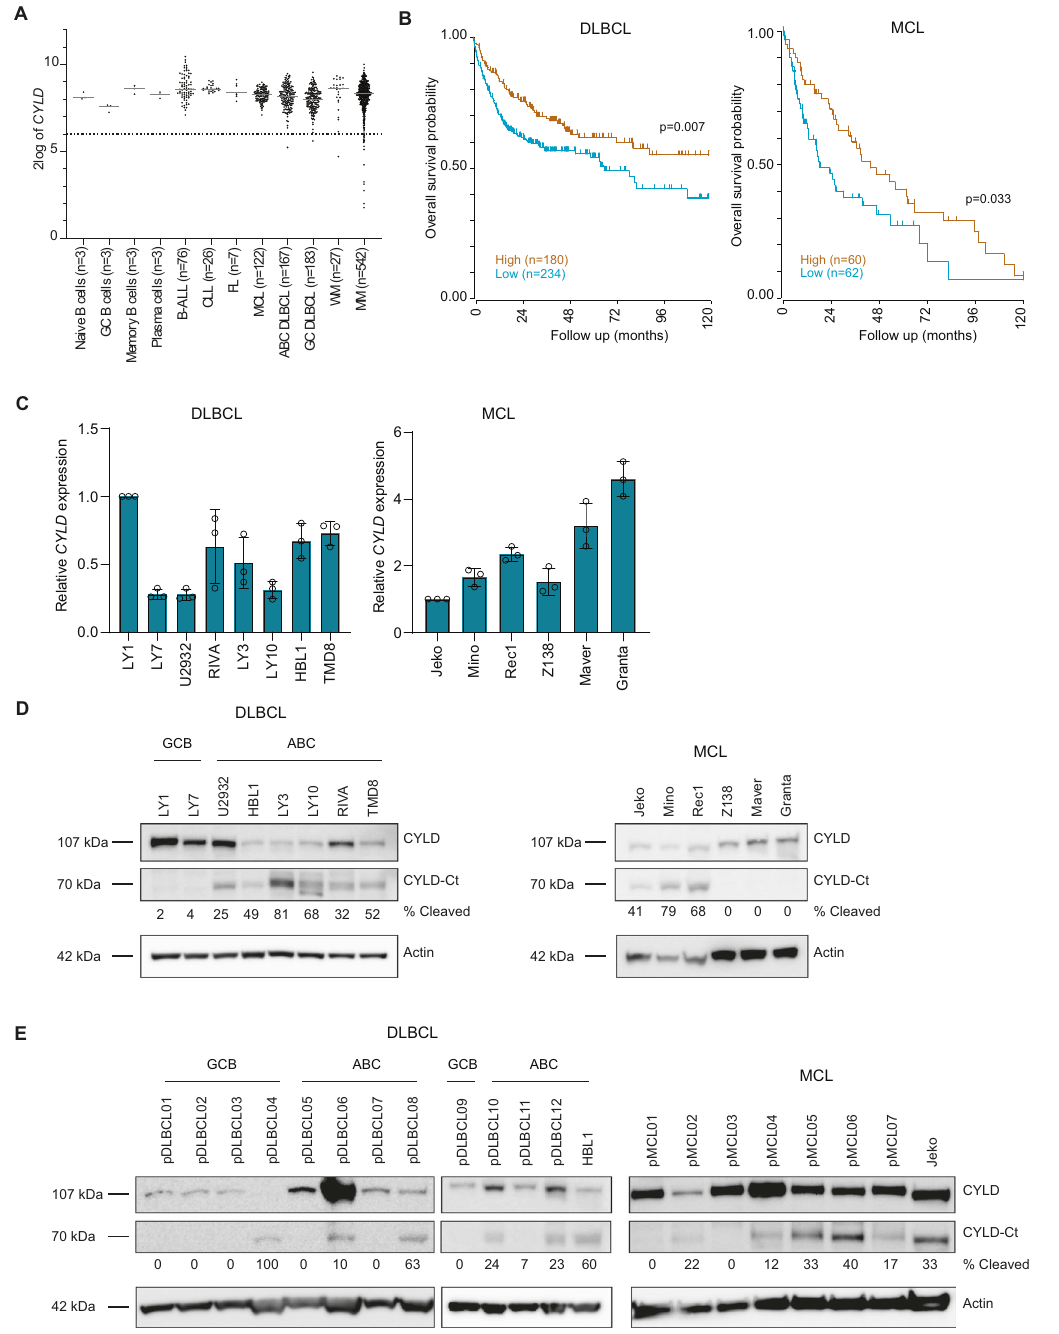
Fig. 1 CYLD is variably expressed in B-cell non-Hodgkin lymphomas (B-NHLs). A CYLD mRNA expression analysis of publically available micro-array datasets of naïve B cells, GC (germinal center) B cells, memory B cells, plasma cells, B-cell acute lymphoblastic leukemia (B-ALL), chronic lymphocytic leukemia (CLL), follicular lymphoma (FL), mantle cell lymphoma (MCL), germinal center B-cell-like diffuse large B-cell lymphoma (GCB-DLBCL), activated B-cell-like diffuse large B-cell lymphoma (ABC-DLBCL), Waldenström ’ s macroglobulinemia (WM) and multiple myeloma (MM). The gray line represents the median expression value within each group. The dotted black line shows the threshold value (i.e., log-transformed probe intensity values of <2 6 ). B Kaplan – Meier survival curve showing overall survival probability in CYLD high versus CYLD low expressing DLBCL and MCL patients. The cut off was based on the average CYLD expression within each cohort. The log-rank test was used to compare the survival distributions of the two groups. C RT-qPCR analysis of CYLD mRNA expression in DLBCL and MCL cell lines. RPLP0 was used as an input control and data are normalized to CYLD expression in LY1 for DLBCL cell lines and Jeko for MCL cell lines. The mean ± SD of three independent experiments performed in triplicate is shown. D Immunoblot analysis of CYLD expression in DLBCL and MCL cell lines using an antibody raised against a C ‐ terminal epitope which detects full-length CYLD and a C ‐ terminal fragment of CYLD (CYLD ‐ Ct). β -actin was used as a loading control. E Immunoblot analysis of CYLD expression in primary DLBCL and MCL samples. β -actin was used as a loading